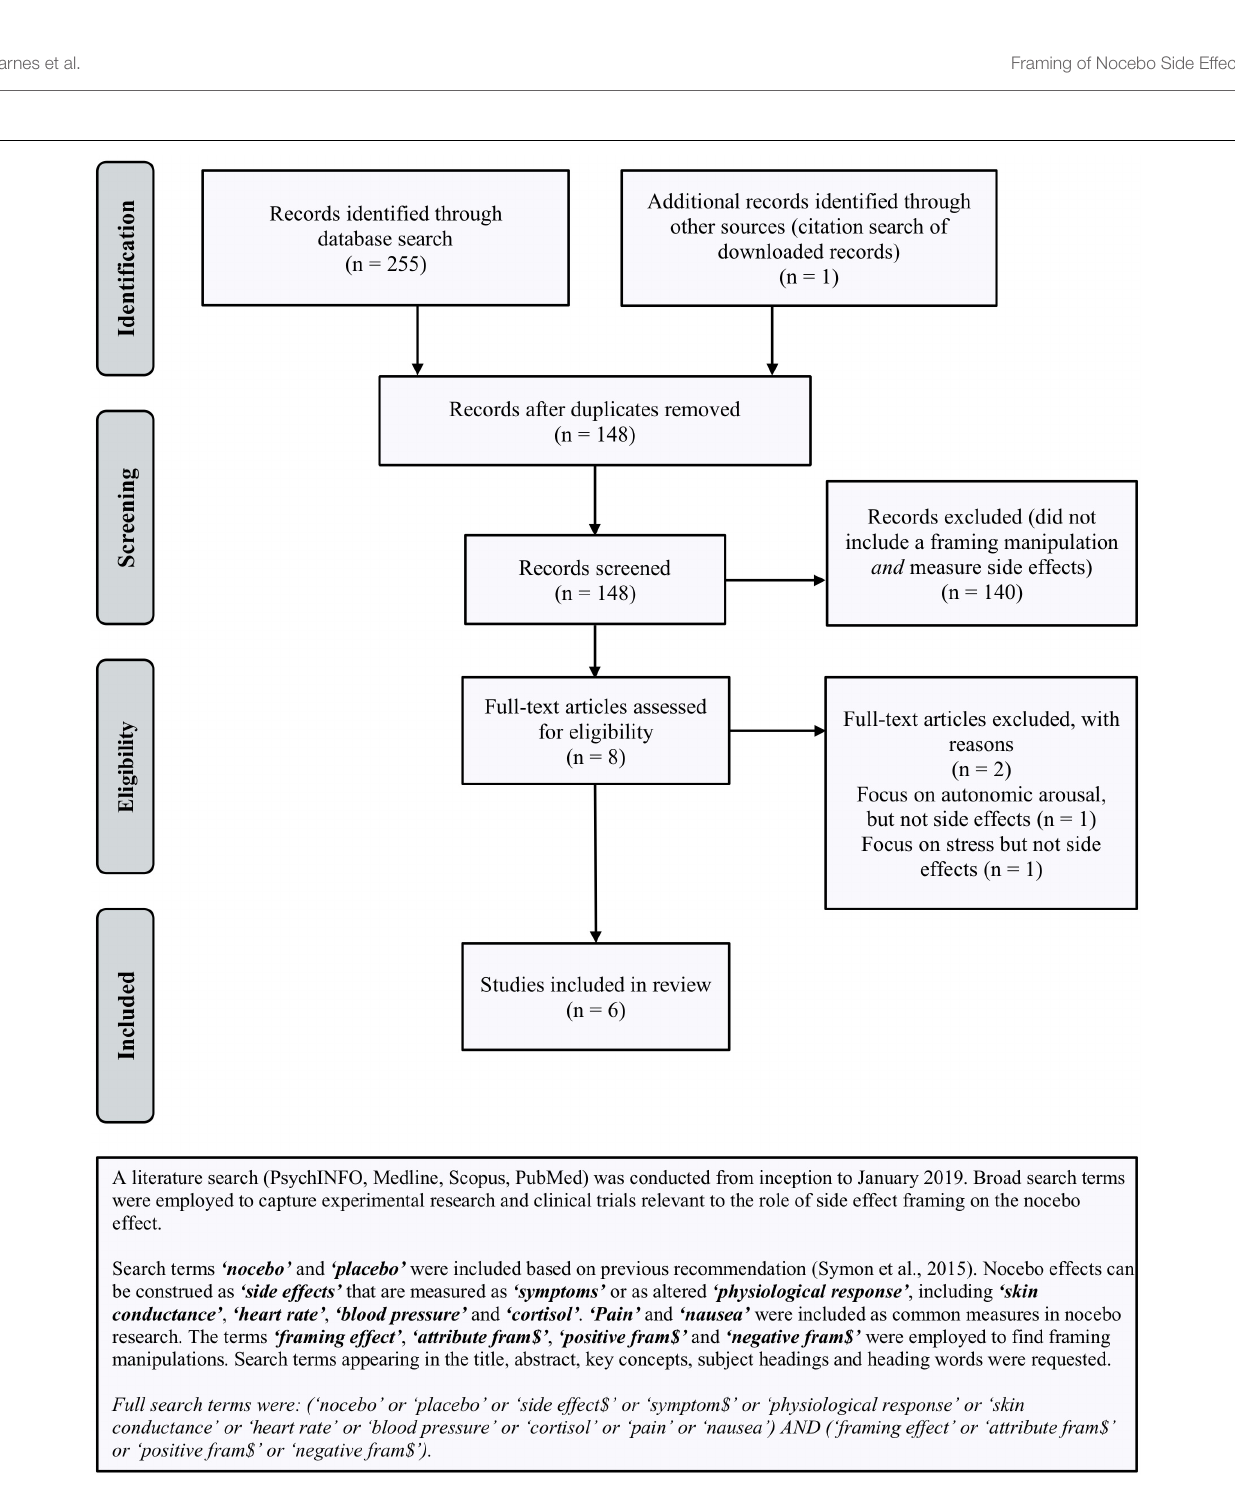
stimulation to healthy volunteers to induce headaches in a 2 (effect type framing: primary or side effect) × 2 (attribute framing: positive vs. negative) + 1 (no-frame control)